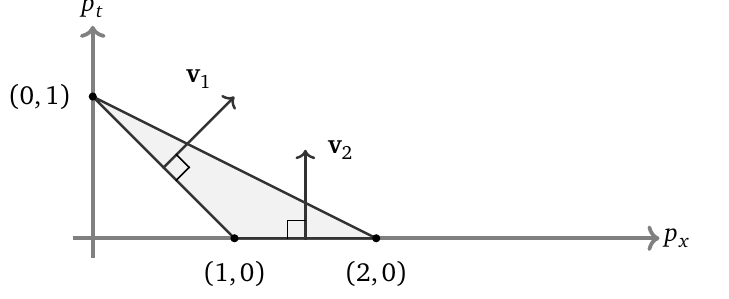
Figure 1: Newton polytope for P ( x , t ) = t + x + x 2 , together with the directions of the region vectors (drawn as normal vectors to the facets in positive t